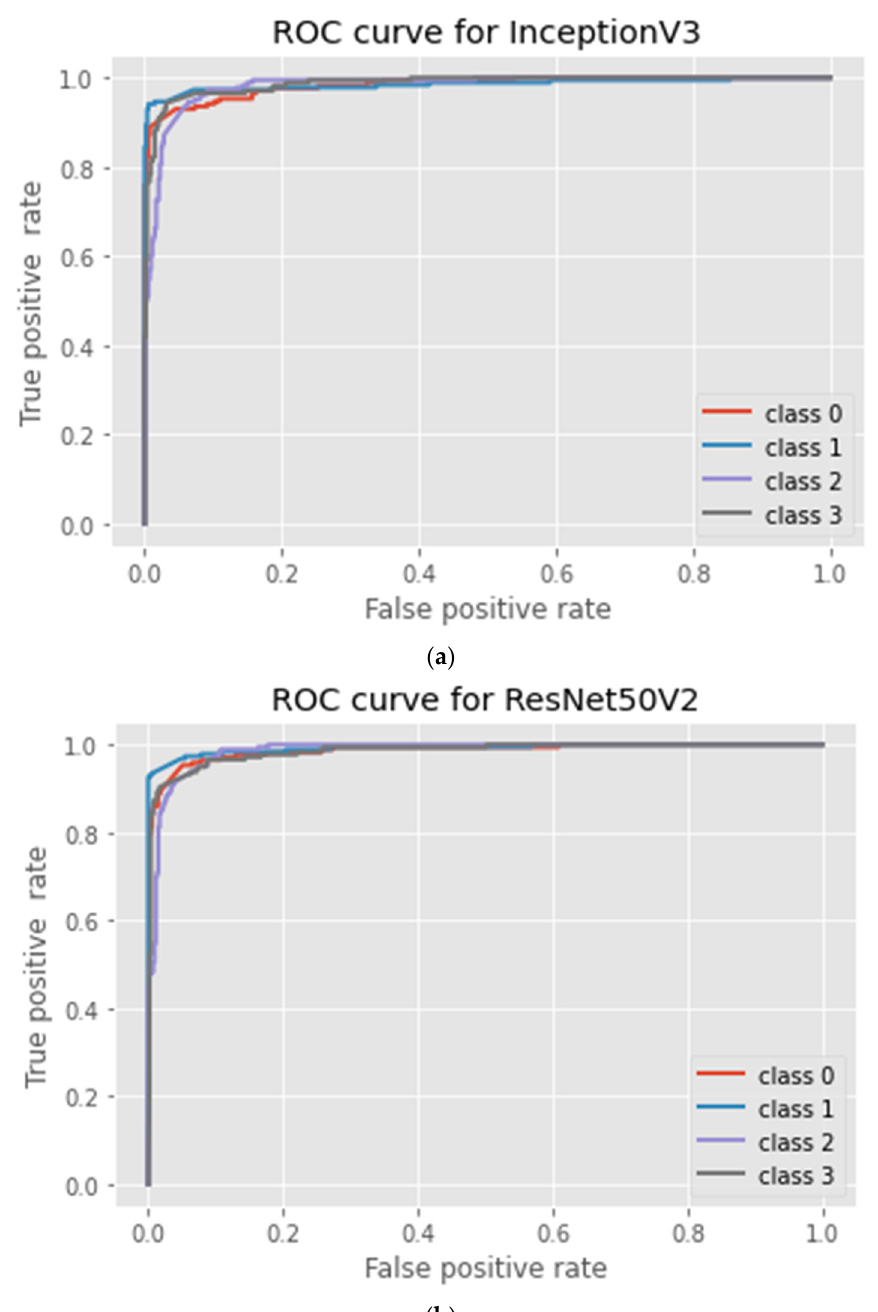
Figure 4. Confusion matrix of DTL models: ( a ) InceptionV3; ( b ) ResNet50V2; ( c ) DenseNet121; and ( d ) Proposed DeneSVM .